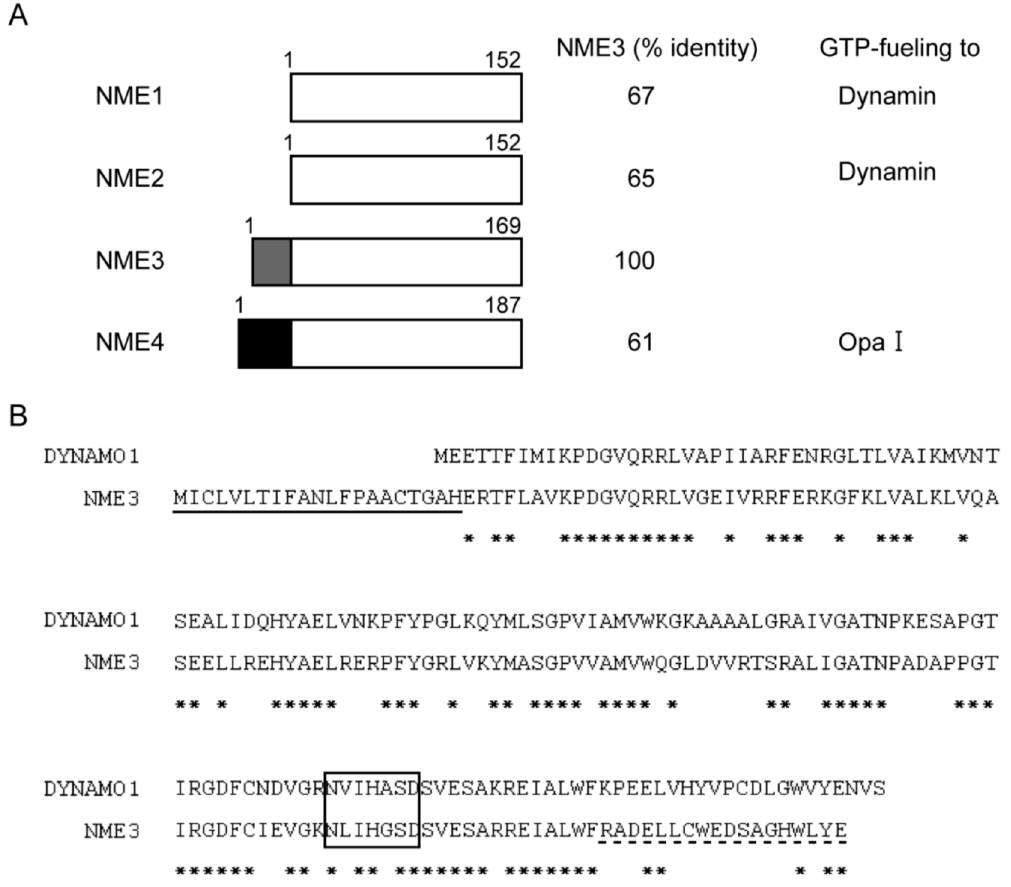
Figure 1. Mammalian nucleoside-diphosphate (NDP) kinase family. ( A ) A schematic view of four NDP kinase family members is from [39]. Amino-acid identity was also indicated between NME1, 2, 3, and 4 by taking NME3 as 100%. Proteins GTP-fueled by respective NME proteins are shown in the right column. Gray and solid boxes are N-terminal hydrophobic segment of NME3 and mitochondrial targeting signal of NME4, respectively. ( B ) Amino acid alignment of DYNAMO1 and NME3. C. merolae DYNAMO1 and human NME3 were aligned by using a Clustal W program. Identical amino acids are represented by asterisks; hydrophobic segment in the N-terminal region of NME3 is marked by an underline. The conserved NDP kinase active site is designated by a box. Amino-acid sequence used for generation of antibody is indicated by a broken-underline.